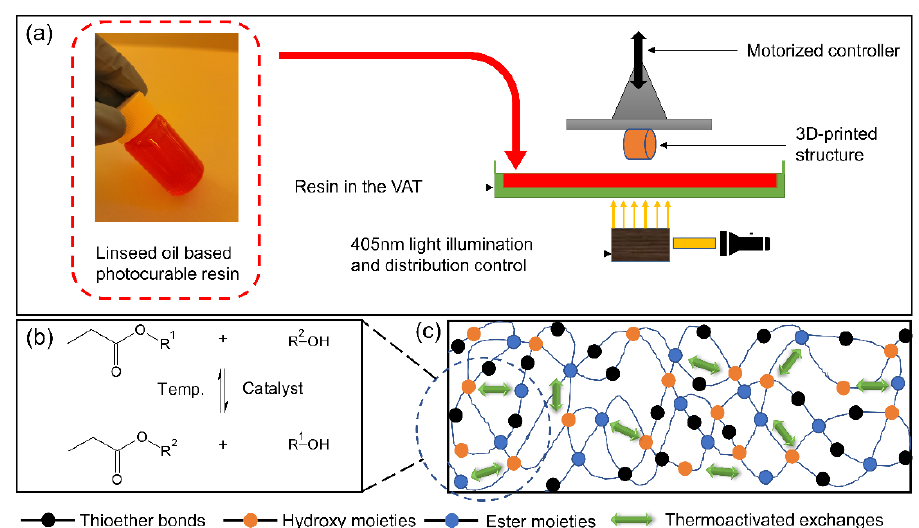
Figure 2. ( a ) Schematics of the digital light processing (DLP) 3D-printing for the printing of bio-based resins, the inset figure shows the actual resin formulation developed for DLP 3D-printing; ( b ) thermoactivated transesterification with the application of temperature and catalyst; ( c ) conceptual diagram of the cured network showing permanent thioether bonds and thermally-activated hydroxy-ester exchange